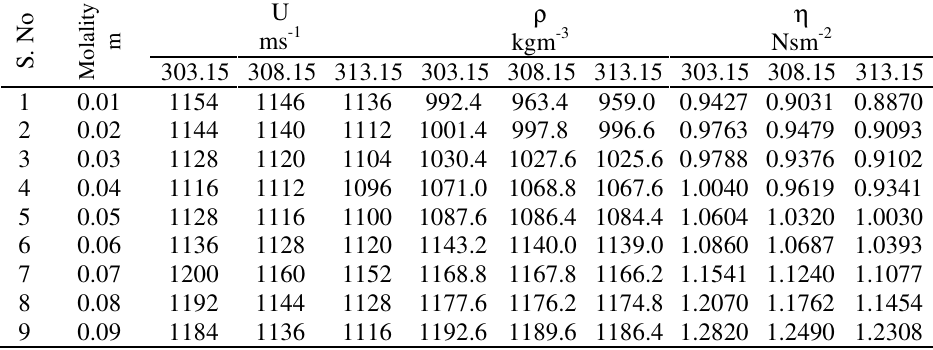
Table 1. Measured values of ultrasonic velocity (U), density ( ρ ) and viscosity ( η ) of 1- 4 Dioxane + chloroform + cyclohexane at 303.15, 308.15 and 313.15